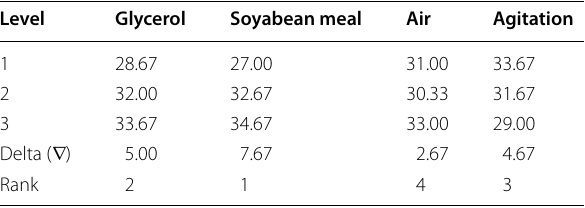
Table 4 Response Table for Means of biomass (DCW: g/L) production by Streptomyces sp.